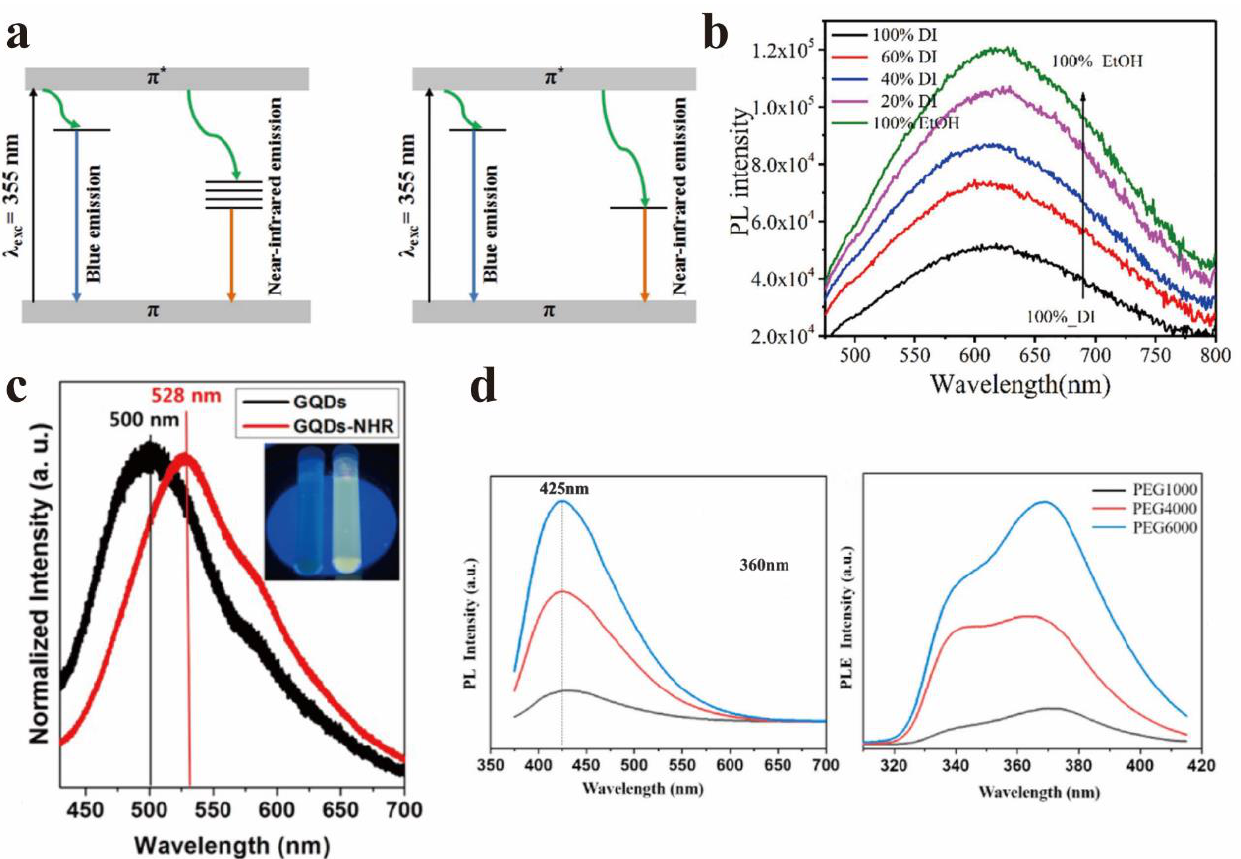
Figure 11. ( a ) Luminous band diagram of GO and ion beam reduction rGO. Reprinted with permission from [64]. Copyright 2018, IOP Publishing Ltd. ( b ) The steady-state fluorescence spectra of GO in mixed solution. Reprinted with permission from [66]. Copyright 2018, Elsevier. ( c ) GQDs ( left ) and GQDs-NHR ( right ) PL photographs excited by 355 nm laser. Reprinted with permission from [67]. Copyright 2013, American Chemical Society. ( d ) Effects of different molecular weight passivators on the luminescent properties of GQDs. Reprinted with permission from [68]. Copyright 2021, Elsevier.